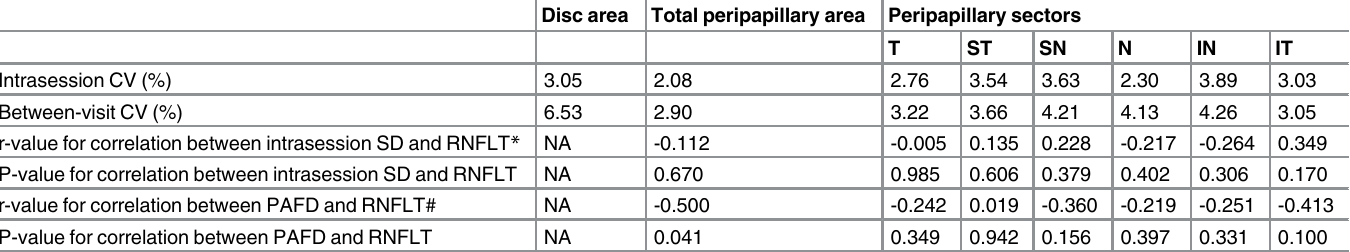
Table 3. Intrasession and between-visit coefficients of variation (CV), correlation coefficients (r) and their significance calculated for the relation- ship between intrasession standard deviation (SD) and the corresponding retinal nerve fiber layer thickness (RNFLT), and peripapillary angioflow vessel-density (PAFD) and the corresponding RNFLT, respectively, in the optic nerve head layer.